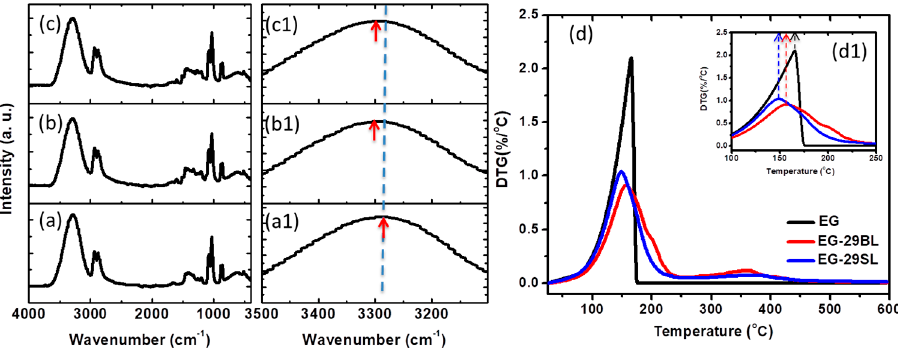
Figure 2. IR spectra of ( a ) ethylene glycol (EG); ( b ) EG-29BL; and ( c ) EG-29SL. Derivative thermogravimetric (DTG) curves of EG and EG/lignin under N 2 atmosphere ( d ). ( a1 – c1 ) represent the enlarged IR spectra within the range of 3100–3500 cm − 1 ; ( d1 ) represents the enlarged DTG curve within the range of 100–250 °C.